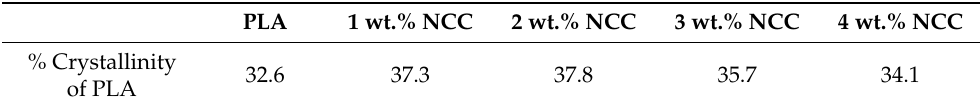
Table 2. The crystallinity of PLA and PLA/NCC [69]. PLA = poly(lactic acid); PLLA/NCC = poly(lactic acid)/nanocellulose crystal. Reproduced with permission from Elsevier.